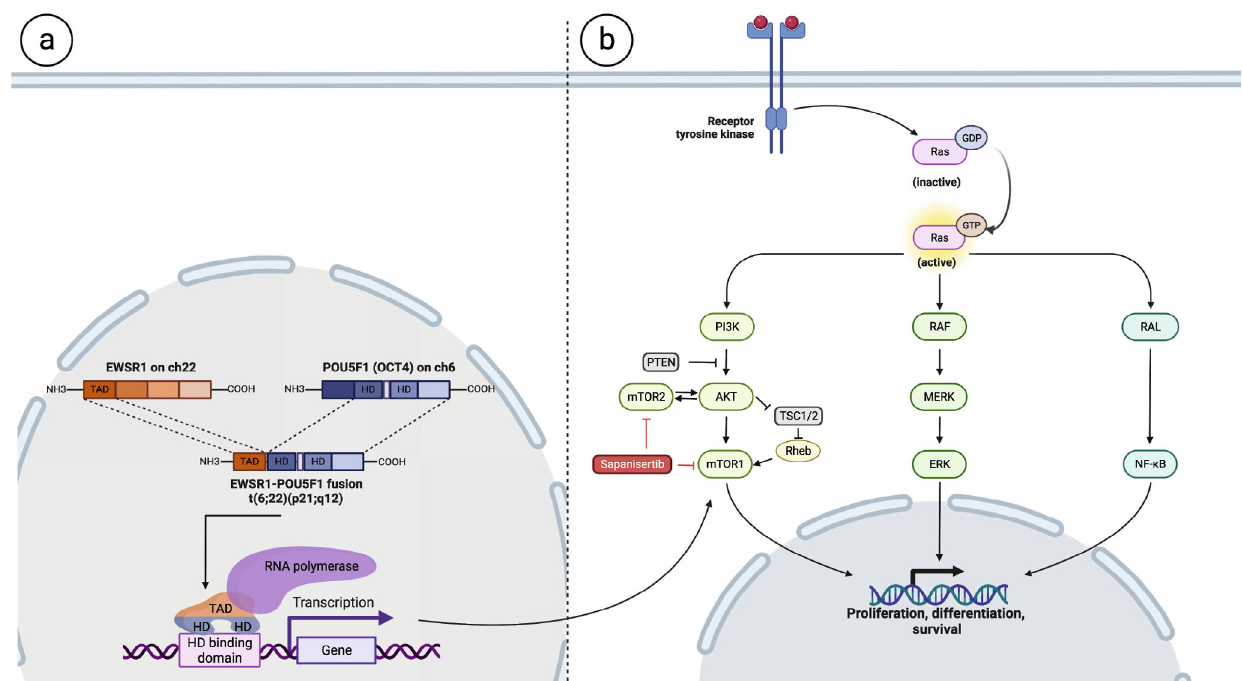
Fig. 4 Hypothesized interaction between genomic alteration and sapanisertib in the two responders. a Schema highlighting the EWSR1- POU5F1 fusion t(6;22)(p21;q12) peptide. POU5F1 (OCT4) belongs to the homeobox gene superfamily and encodes a transcription factor that act as a master regulator of development. POU5F1 has preserved homaeodomains (HD) that bind DNA. The fusion peptide brings the HD of POU5F1 in proximity to N-terminal transcriptional activation domain (TAD) of EWSR1. This fusion peptide hypothetically leads to enrichment of EWSR1-related signaling pathways including the mTOR signaling pathway, p53 signaling pathway, and WNT signaling pathway. b Schema depicting the downstream signaling pathways following the activation of receptor tyrosine kinase including the RAF/MERK/ERK and the PI3K/ AKT/mTOR pathways. Figure was created using